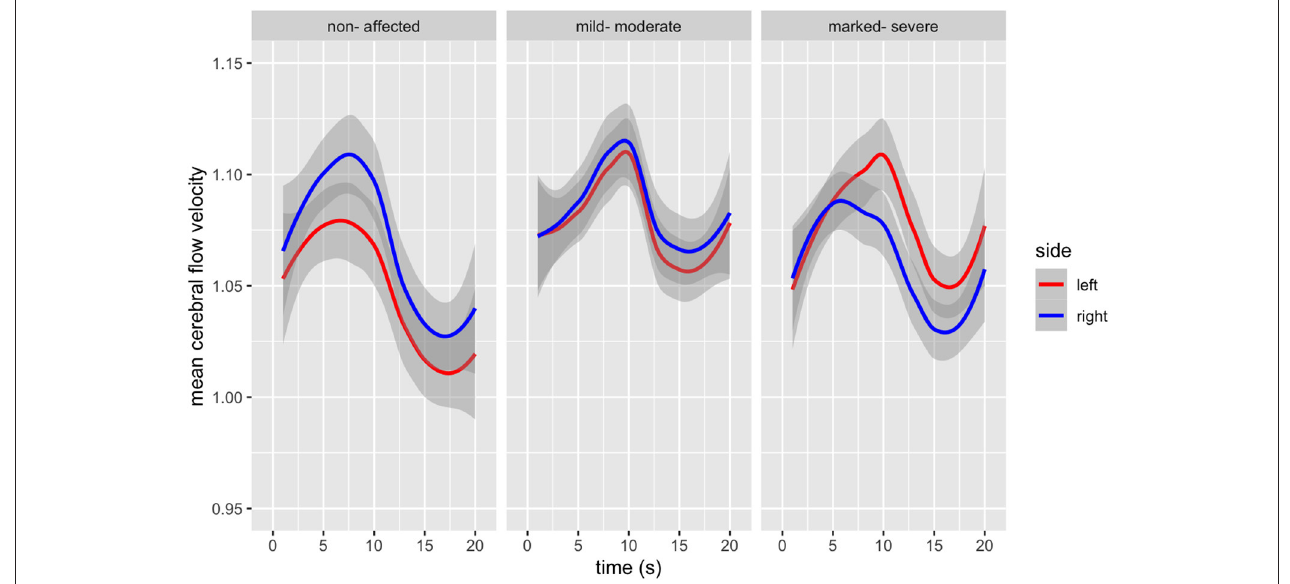
FIGURE 1 | Bilateral Mean Flow Velocity changes from baseline in the Middle Cerebral Artery during the duration of the TMT-A (in seconds), according to psychopathological symptom load [ F (6, 1,792) = 17, p <